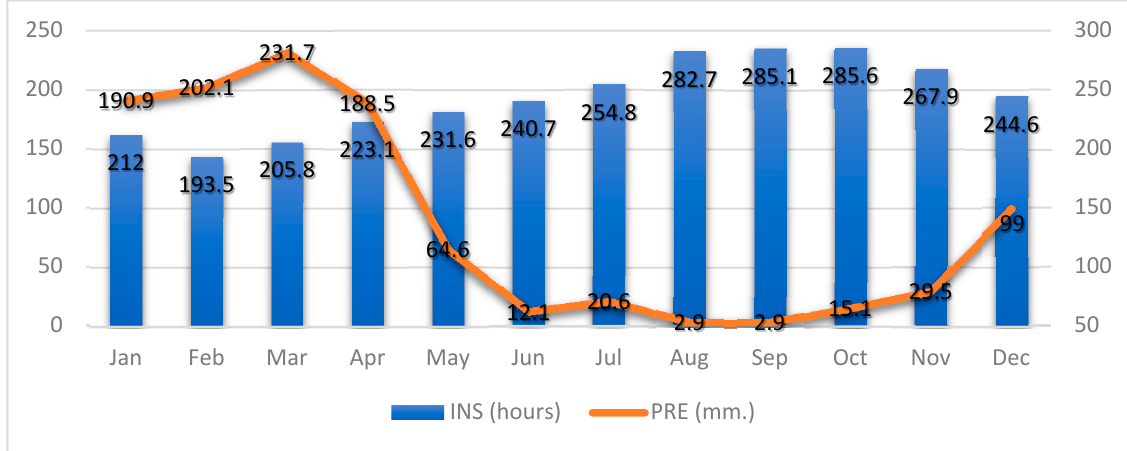
Figure 7. Total insolation and accumulated precipitation in Cariri Cearense—averages from 1981 to 2010. Data source: INMET [86], adapted for the study.